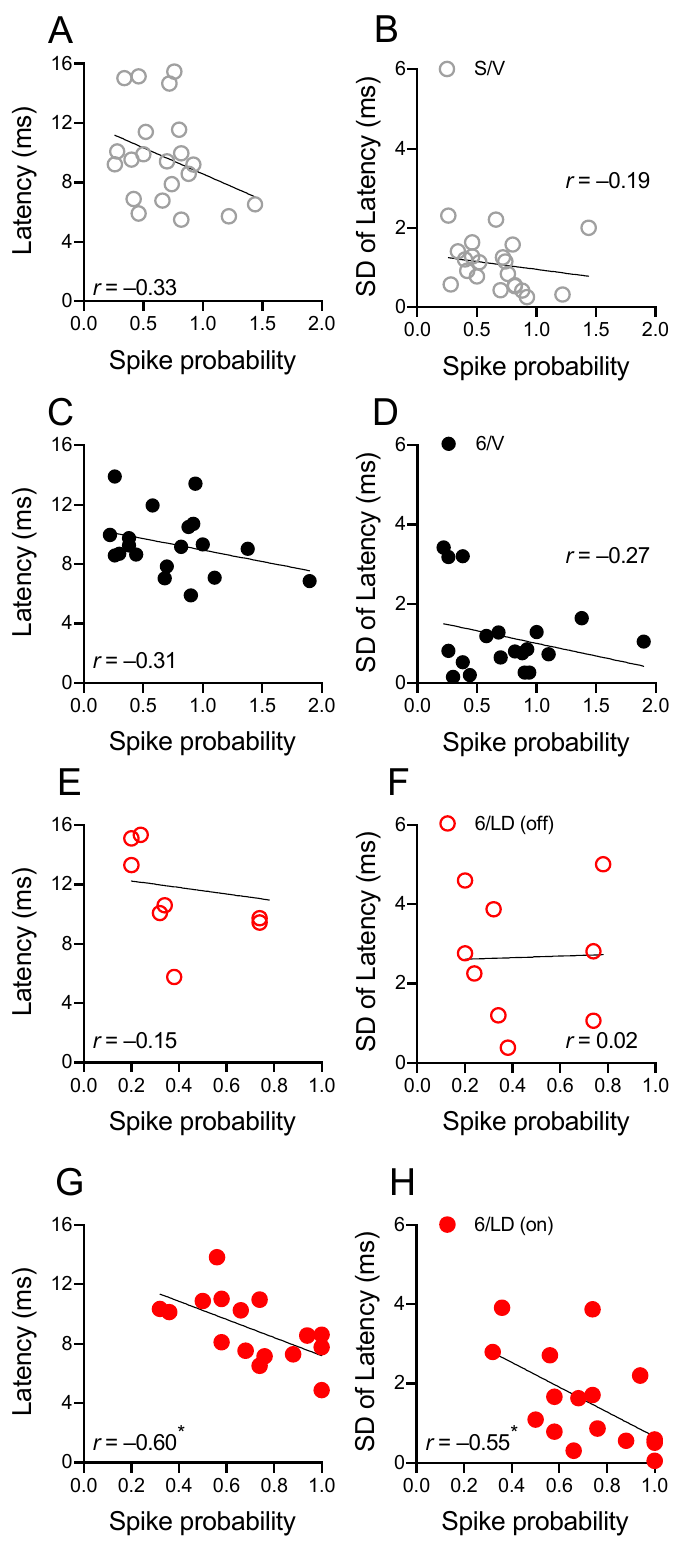
Figure 4. Spike probability and the latency to the first spike correlate in LID. ( A – F ) There was no correlation between the latency to the first spike and spike probability or the standard deviation of latency to the first spike and spike probability in the S/V, 6/V, and 6/LD groups ( p > 0.05, Pearson’s r ). ( G ) There was a negative correlation between the latency to the first spike and spike probability and ( H ) a negative correlation between the latency to the first spike and spike probability (* p < 0.05, Pearson’s r ). Results are derived from n = 10/21 animals/cells in the S/V group, n = 6/19 animals/cells in the 6/V group, and 12/9—16 animals/cells in the 6/ LD